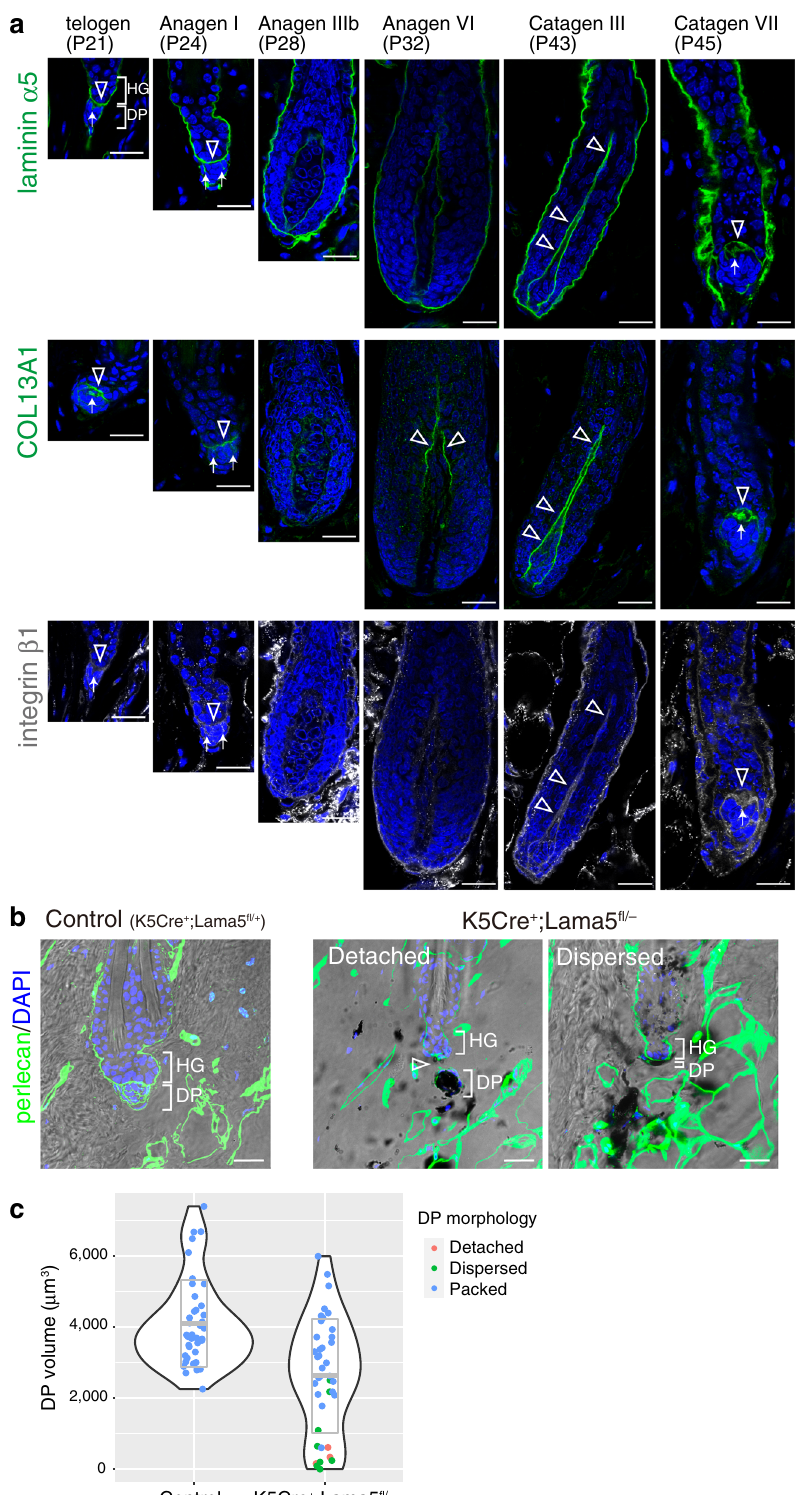
Immunohistochemistry and imaging . Whole-mount immunostaining of mouse dorsal skin was performed as follows 15 . Brie fl y, mouse skin tissues were dissected and fi xed with 4% paraformaldehyde (PFA)/PBS for 1h at 4°C, and embedded in OCT compound after washing with PBS. For acetone fi xation, dissected skin was directly embedded in OCT compound. Skin sections (150 μ m thick) were made using a cryostat (Leica, Wetzlar, Germany) and washed with PBS. Acetone fi xation was performed by placing skin sections in − 30 °C acetone for 15min, followed by acid treatment with 0.1N HCl/0.1 N KCl for 15min after washing in PBS.